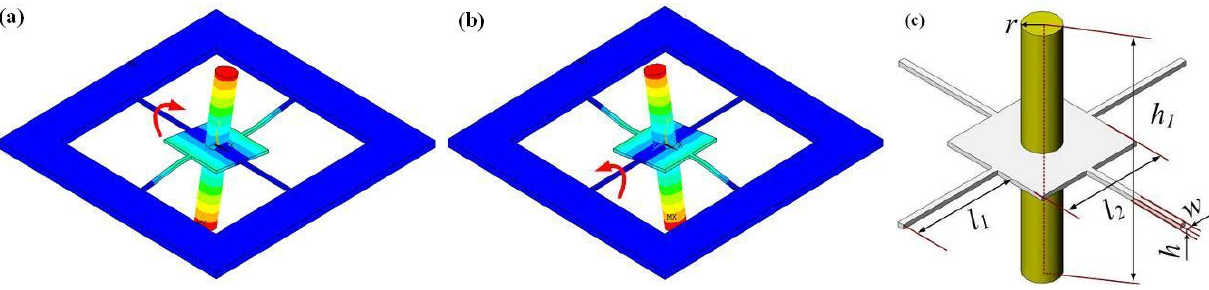
Figure 1. The two operational modes and the main structural parameters of RMG. (a) The driving mode. (b) The sensing mode. (c) The main structural